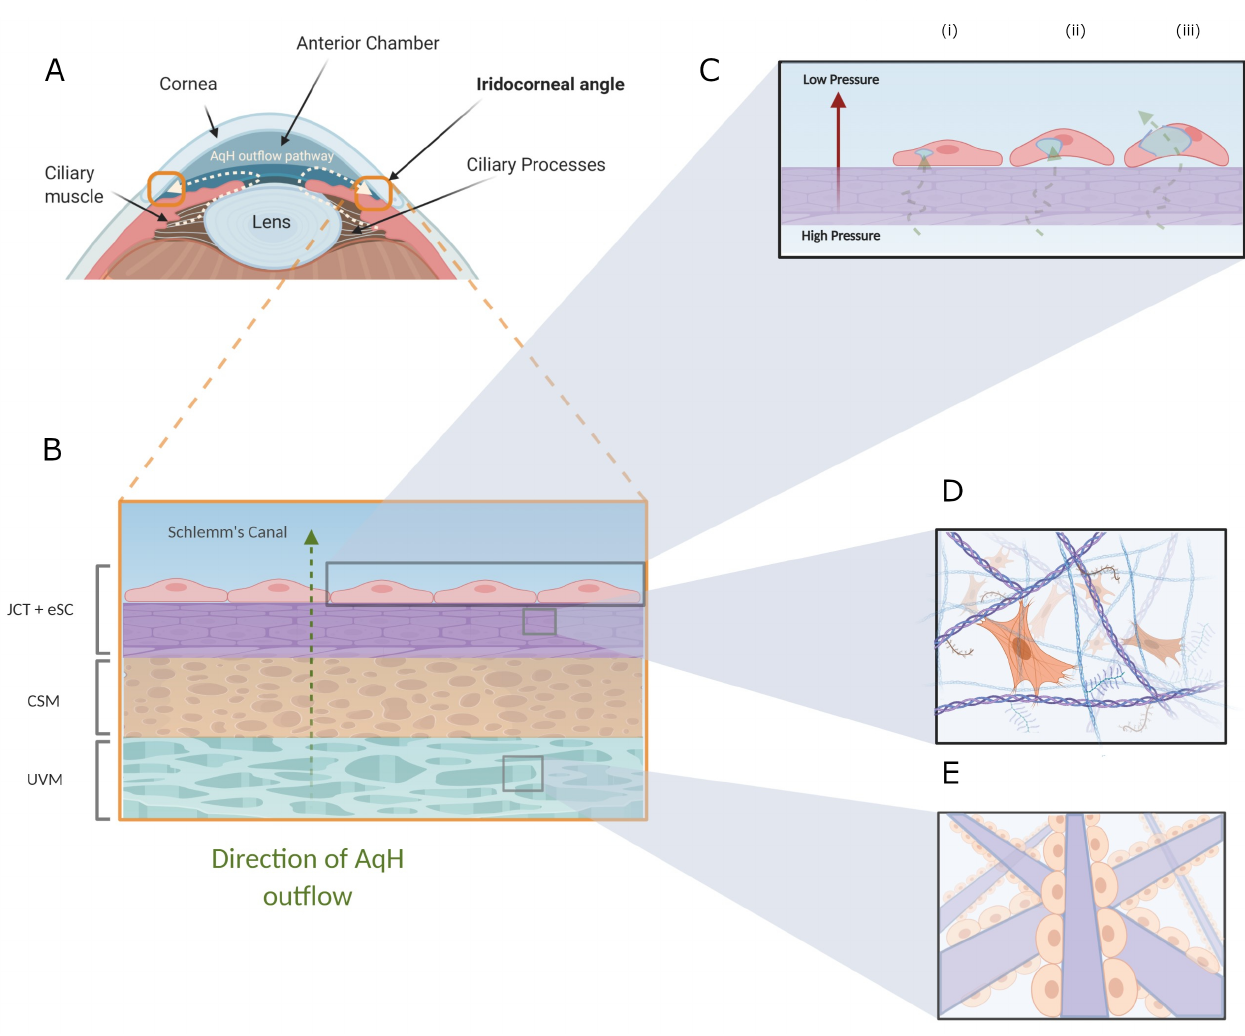
Figure 1. The AqH outflow pathway. ( A ) Diagram of the anterior chamber of the eye and direction of AqH movement towards the iridocorneal angle. The AqH outflow pathway within the iridocorneal angle is indicated by the bold orange square. ( B ) A magnified section of the AqH outflow pathway is presented with distinction and the 3 segments of the TM: Uveal Meshwork (UVM), Corneoscleral Meshwork (CSM), Juxtacanalicular Tissue and inner wall endothelia of the Schlemm’s canal (JCT and eSC). Green dotted arrow represents the direction of aqueous humour (AqH) flow through the TM and eSC, into the Schlemm’s canal. ( C ) eSC giant vacuole (GV) formation is presented: (i) Pressure builds on the basal side of the cell, opening micron-sized pores. (ii) AqH flows through the micron-sized pore, inducing a large cellular deformation (iii) Formation of GV structures, AqH enters into the lumen of the Schlemm’s canal. ( D ) Magnification of the JCT section, representing fibroblast-like TM cells sparsely embedded into a connective tissue matrix. ( E ) Magnification of the UVM section (also representative of the CSM section), with TM cells resting on collagen beams as a continuous monolayer, displaying an endothelial